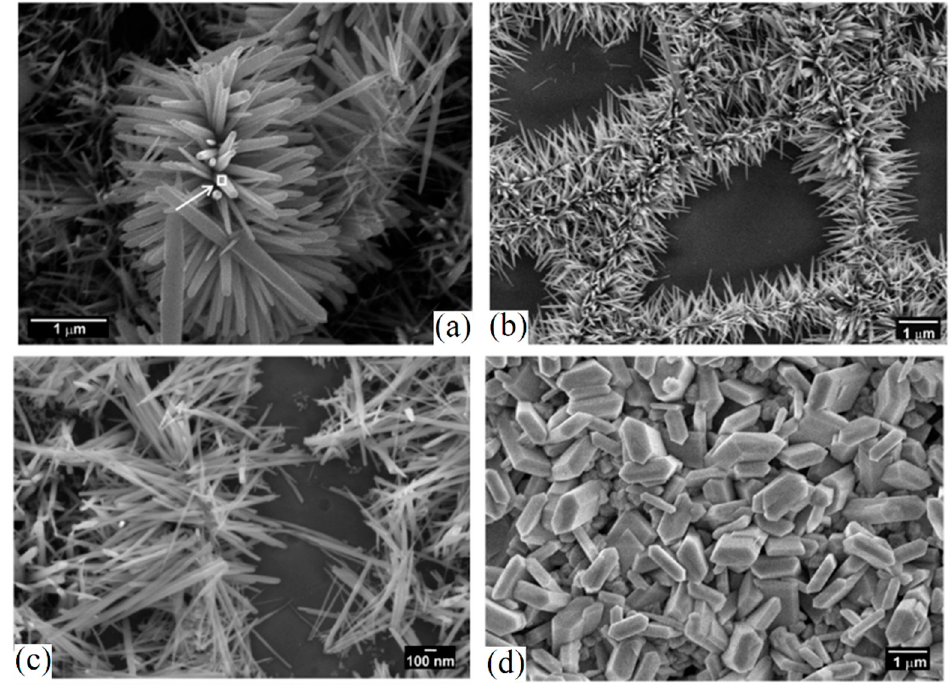
Figure 10. FESEM micrographs of hydrothermal process carried out on ZnO NFs at different conditions; ( a ) 1 min electrospinning and 1 h autoclaving ( b ) 2 min electrospinning and 2 h autoclaving ( c ) 10 min